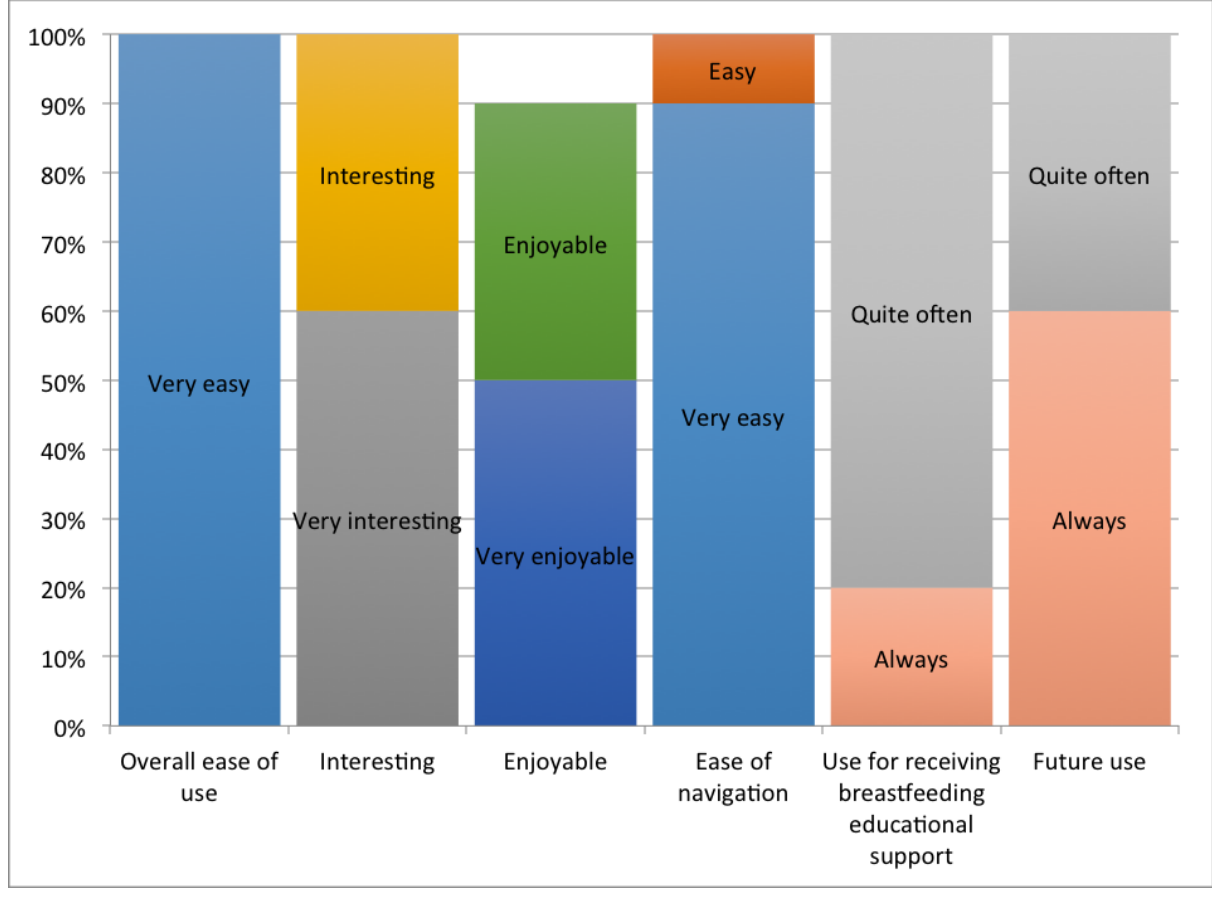
Figure 4. Frequency distribution of the program